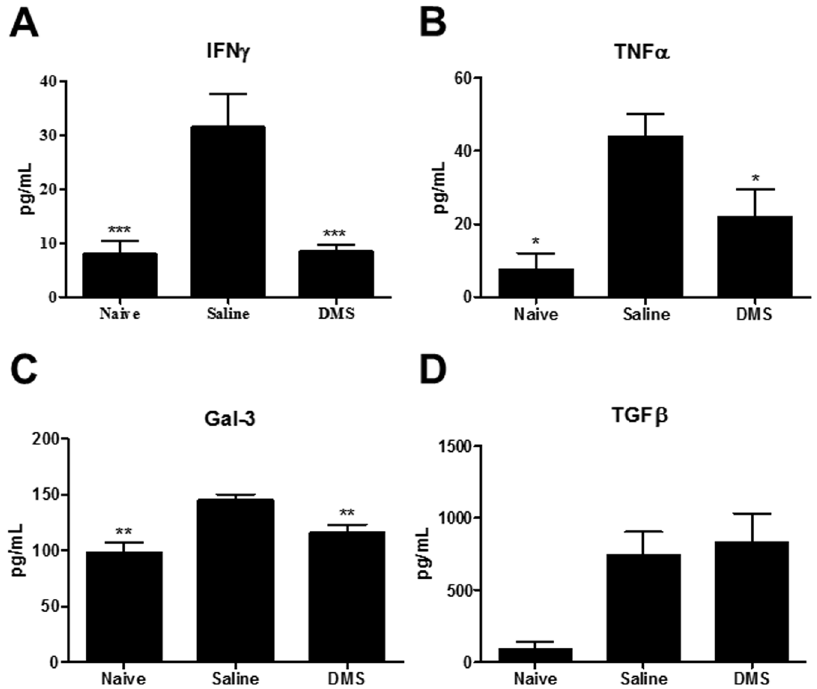
Figure 2. Modulation of systemic cytokine production in chronic chagasic mice treated with DMS. Concentrations of IFN γ ( A ), TNF α ( B ), Gal-3 ( C ) and TGF β ( D ) in the sera from naive and chagasic mice treated with saline or DMS. Values represent means ± SEM of 10 mice/group. *** P < 0.001; ** P < 0.01; * P < 0.05 compared to saline